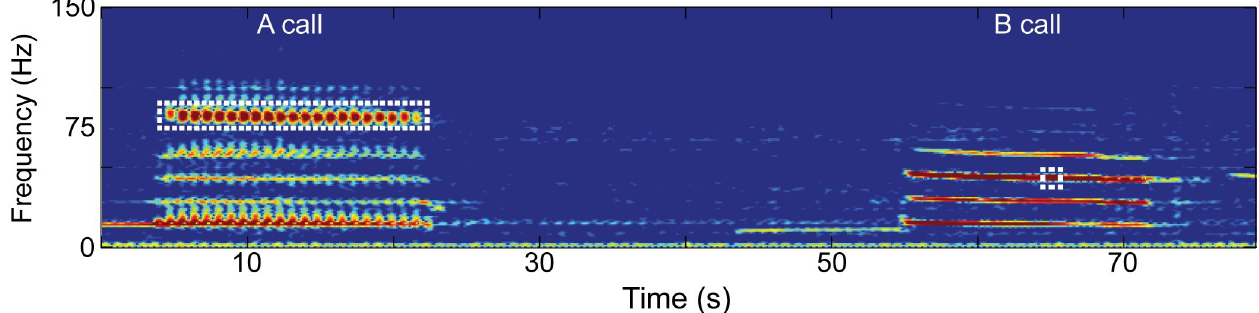
Fig 2. Northeast Pacific blue whale A and B call. Calls were recorded on October 17, 2015 at site N. The dashed box indicates the overtone (A call) and harmonic and time point (B call) for which frequencies were used to compare between years.